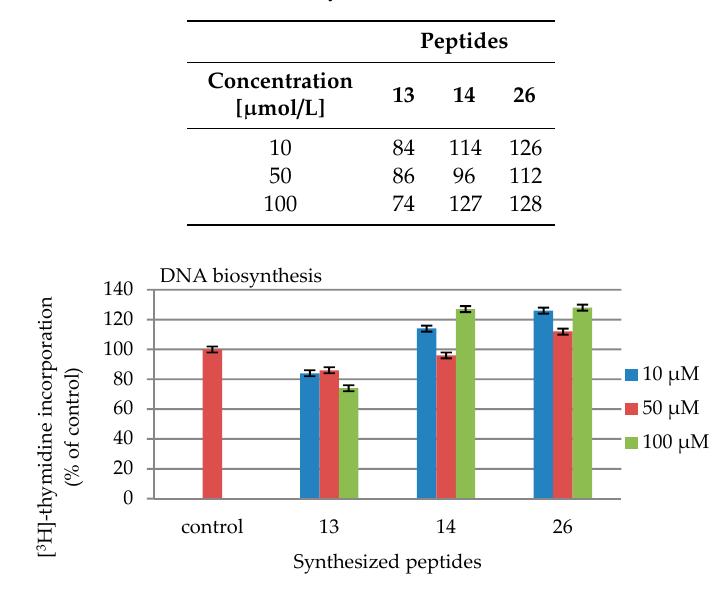
Figure 3. Influence of the synthesized peptides 13 , 14 and 26 on DNA biosynthesis.